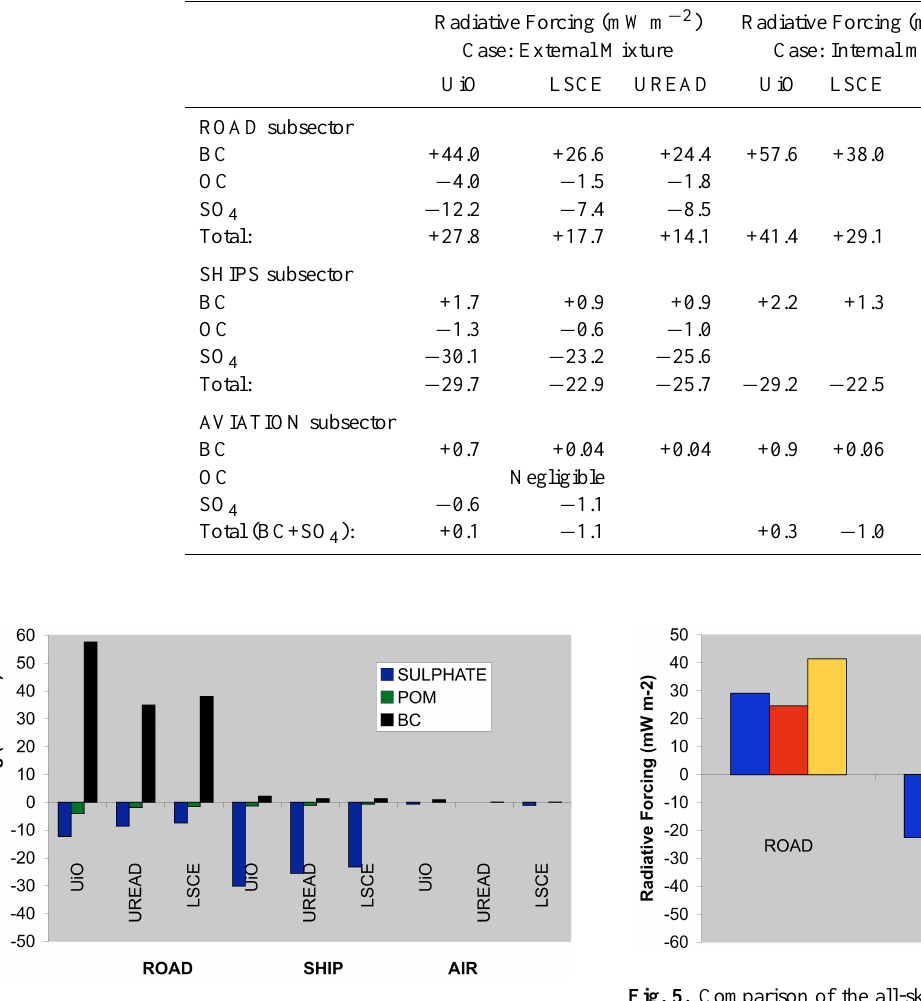
Figure 4. Fig. 4. Global-mean all-sky direct aerosol radiative forcings (mWm − 2 ) by subsectors and for each of the three aerosol com- ponents: BC, OC and SO4. The results are presented for the three models. For all models, the BC aerosols are considered internally mixed.